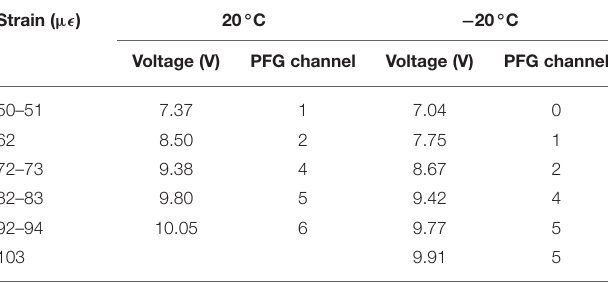
TABLE 2 | Measured PZT strain-voltage and PFG activation vs.